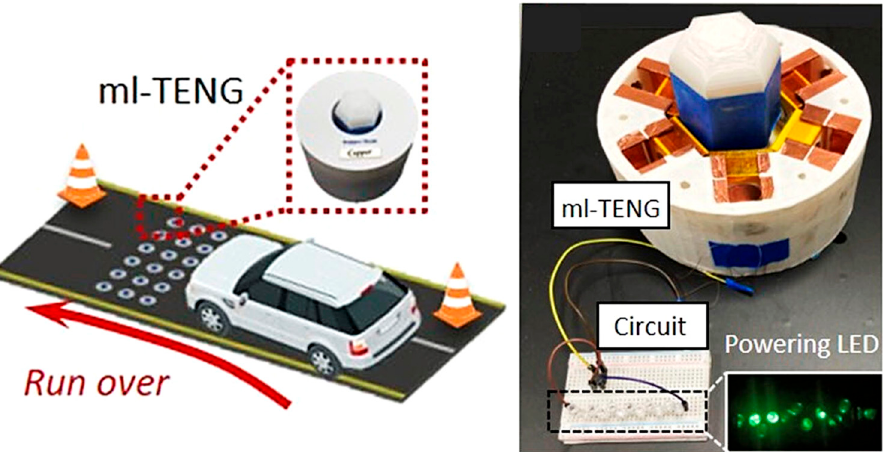
Figure 5. Magnetic-lifting TENG for energy harvesting application on the road (Reprinted with permission from Ref. [57]. 2021, AIP Publishing)